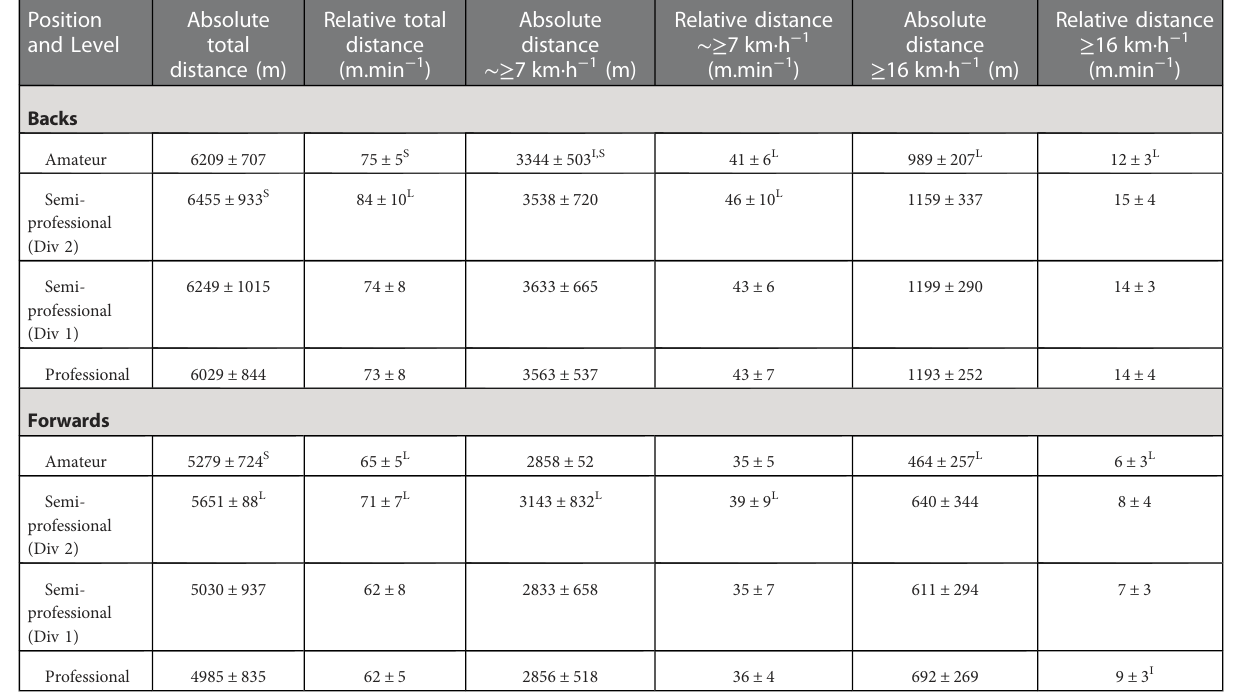
TABLE 2 Absolute and relative distance measurements (mean±SD) for forward and back positions in different levels of rugby competition. Position and